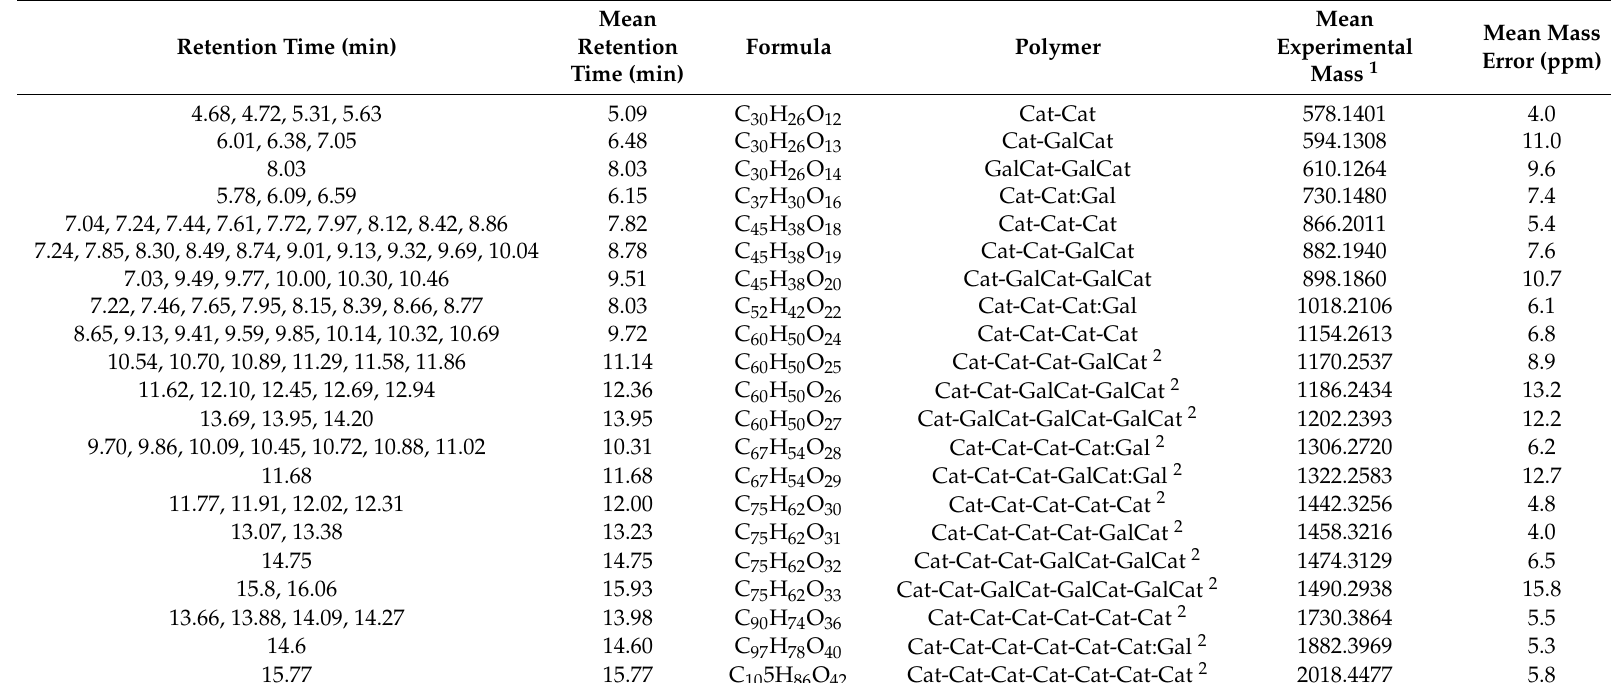
Table 1. Retention times, chemical formulae and mean measured experimental mass of identified compounds. Polymer subunits are indicated as follows: (epi)catechin = Cat, (epi)catechin-3- O -gallate = Cat:Gal, (epi)gallocatechin = GalCat, and (epi)gallocatechin-3- O -gallate =